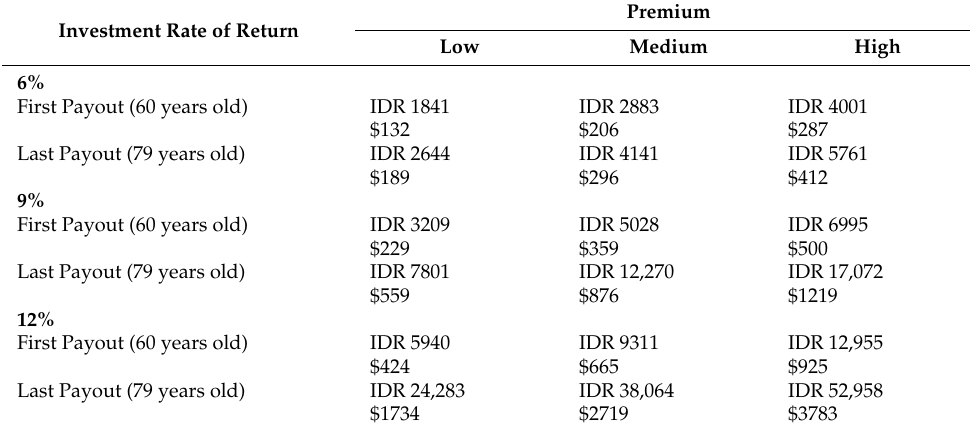
Table 2. Present values of monthly retirement payout, Director, IV/d (in thousand